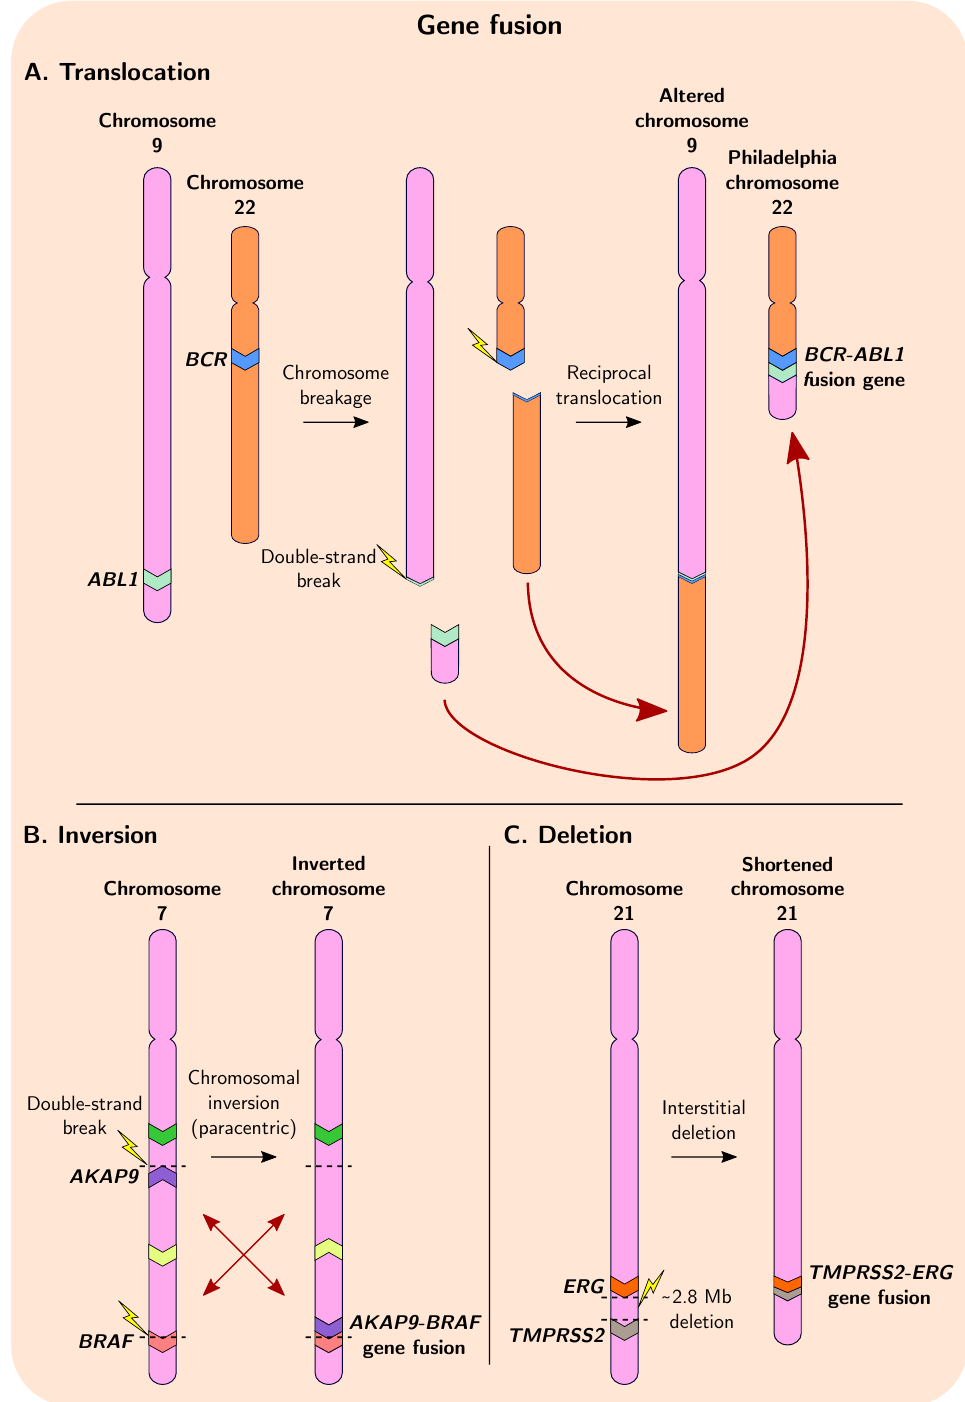
Figure 2. Overview of gene fusion in cancer with examples of well-known fusion events. ( A ) Re- ciprocal translocation between different chromosomes can result in gene fusion, such as during the well-characterised fusion of BCR and ABL1 in CML. ( B ) Chromosomal inversion events can give rise to gene fusions, including the AKAP9-BRAF fusion found in thyroid carcinomas [105]. Inversion events can be pericentric (spanning the centromere) or paracentric (excluding the centromere) ( C ) Deletion of chromosomal segments between two genes can result in their fusion, which constitutes a large proportion of the fusion events forming TMPRSS2-ERG in prostate